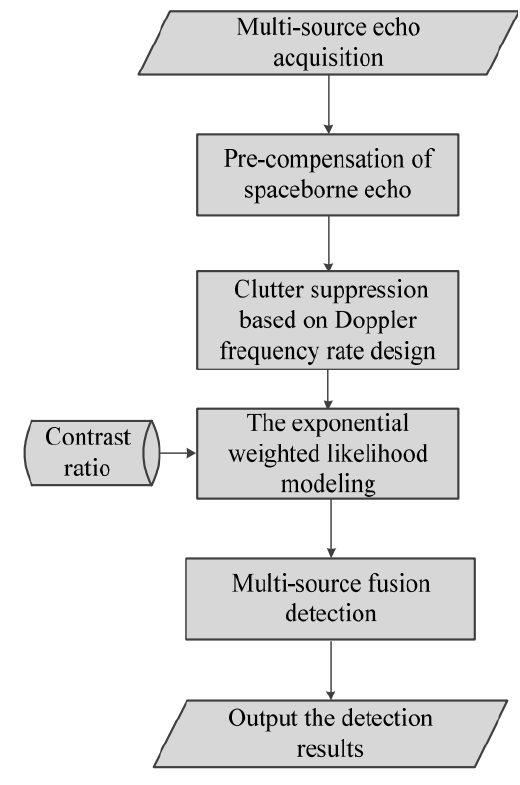
Figure 3. The flow chart of multi-source fusion CFAR detection